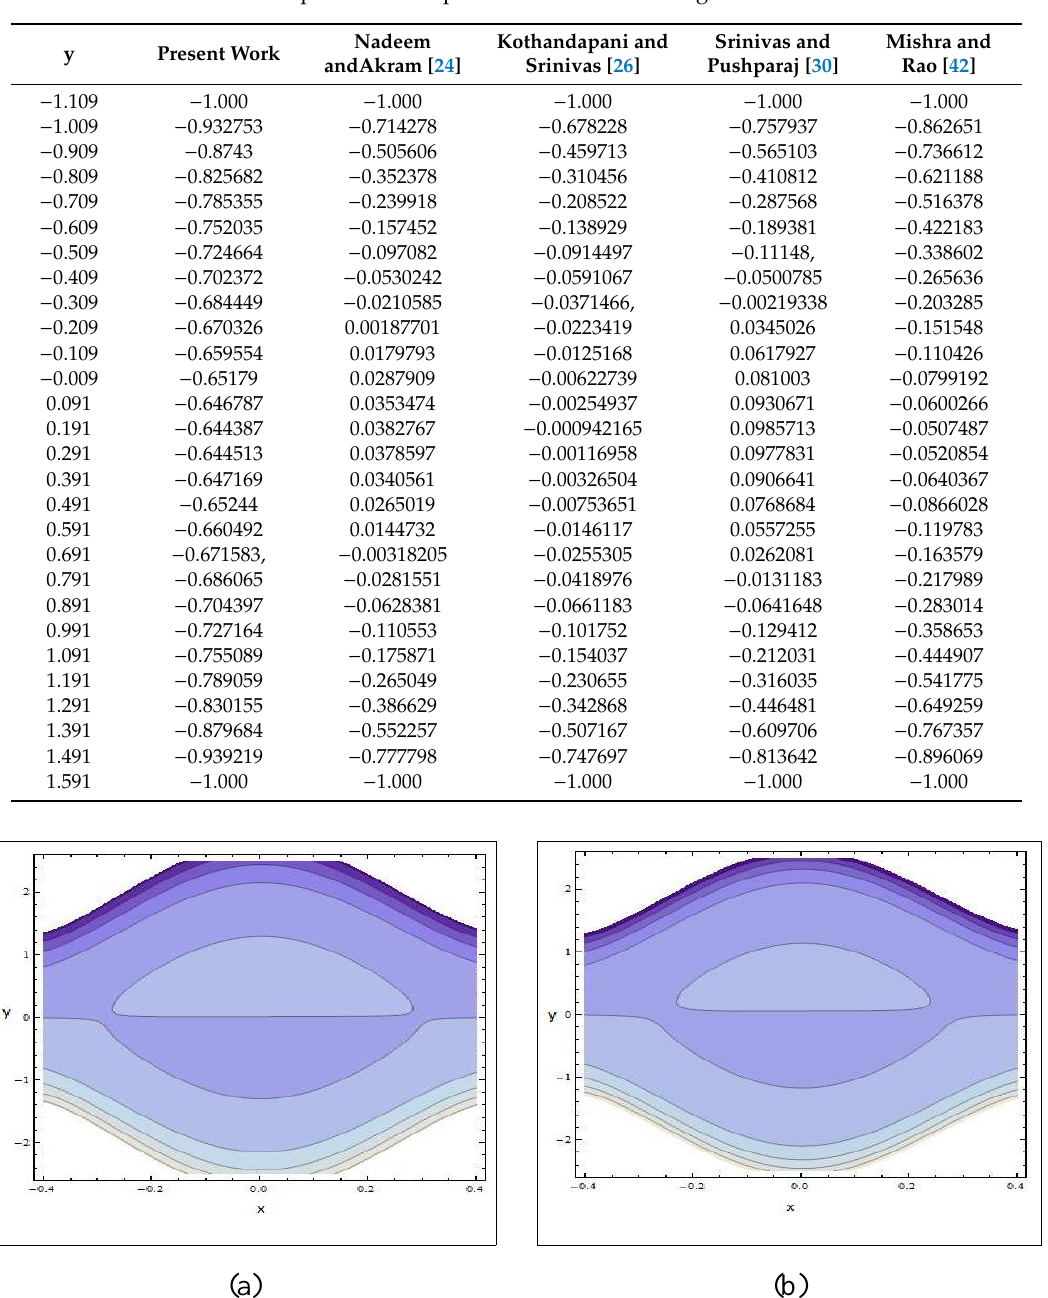
Figure 16. Stream lines for different values of λ parameters are a = 0.7, b = 0.7, d = 1, Θ = k = 0.1, Q =